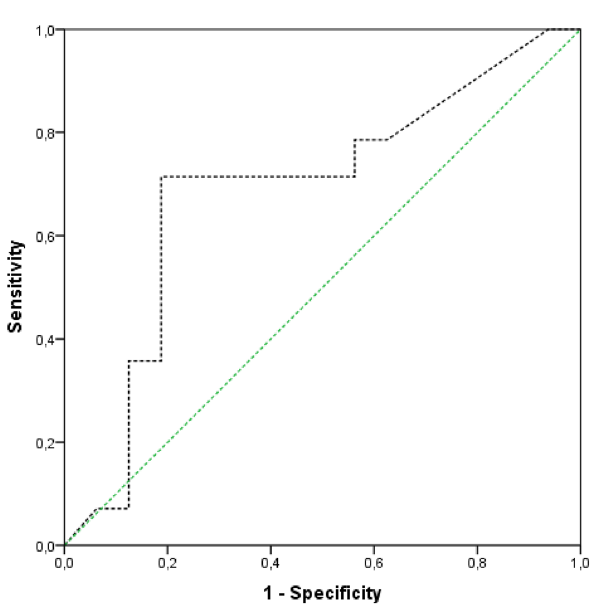
Figure 1. Area under the receiver operating characteristic (ROC) curve (AUC) of the calprotectin lateral flow assay against the modified EBJIS 2021 definition. AUC = 0.69; EBJIS 2021, European Bone and Joint Infection society definition of periprosthetic joint infection published in